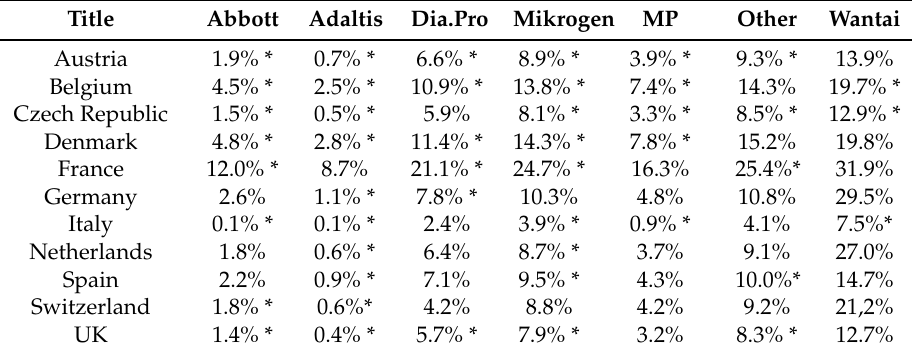
Table 3. Calculated seroprevalence rates for the general